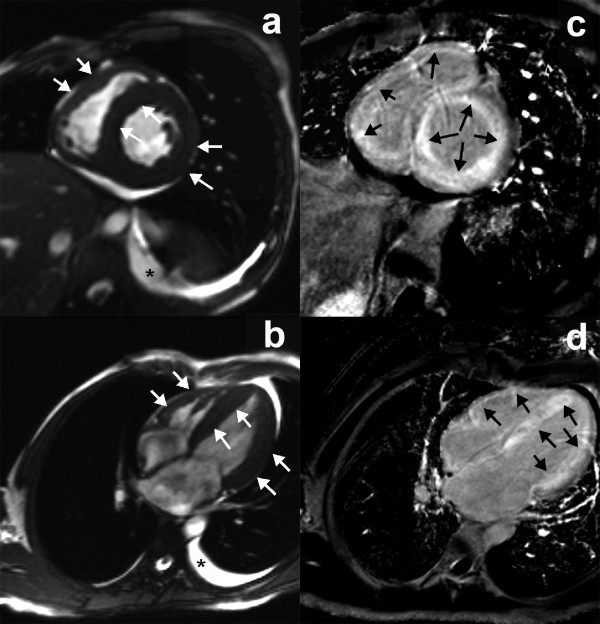
LGE of cardiac amyloidosis. CMR demonstrated global LV and RV wall hypertrophy (a and c) (white arrows), diffuse transmural LGE (b and d) (black arrows), and mild left-sided pleural effusion (*) in a 39-year-old male patient with cardiac amyloidosis who underwent cardiac transplantation and was proven by surgical pathology specimen.